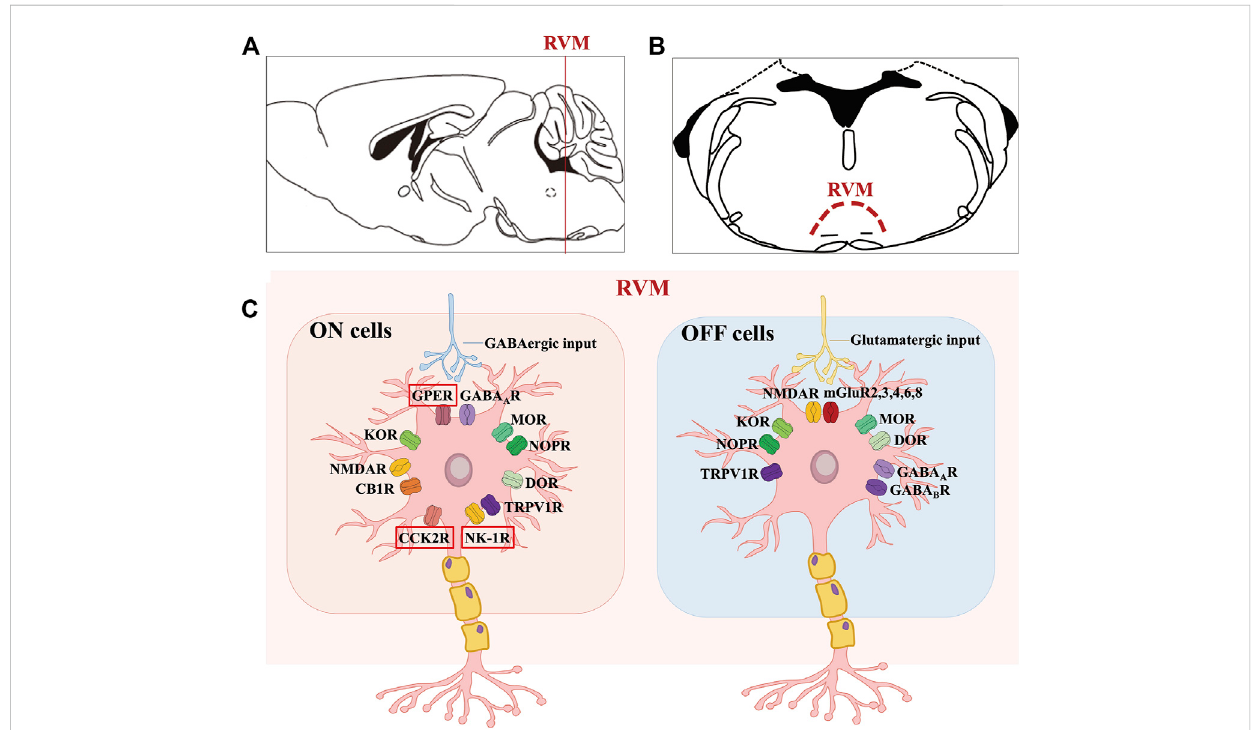
FIGURE 1 MolecularcharacteristicsoftheONandOFFcellsinRVM. (A,B) showstheanatomicallocationoftheRVMnucleusinthemousebrain. (C) showsthat GPER along with opioid, cannabinoid, GABA, TRPV1, glutamate, NK-1 and CCK2 receptors are expressed on ON cells, where GPER, CCK2R and NK-1R may be speci fi c. Likewise, OFF cells mainly express opioid, cannabinoid, GABA, TRPV1 and glutamate